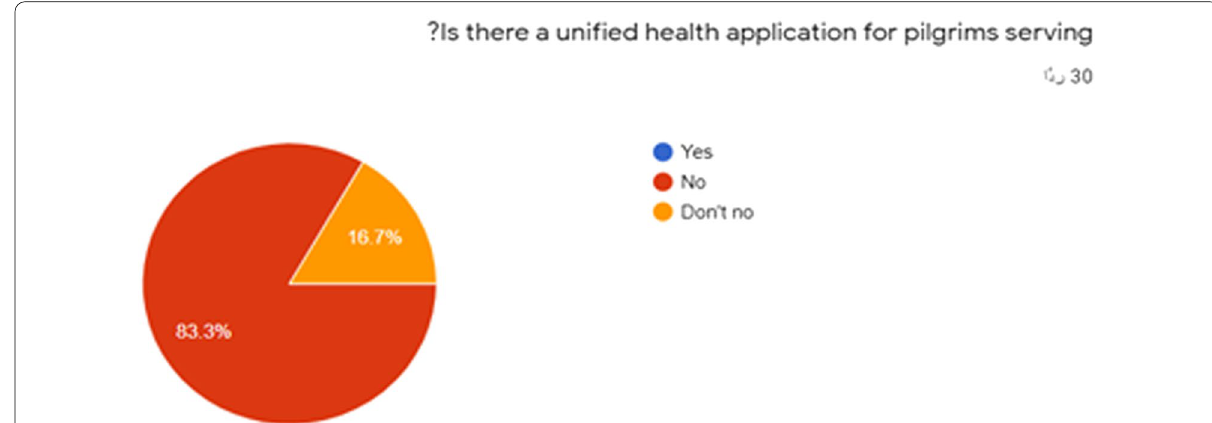
Fig. 4 Opinions about the percentage of unified health application